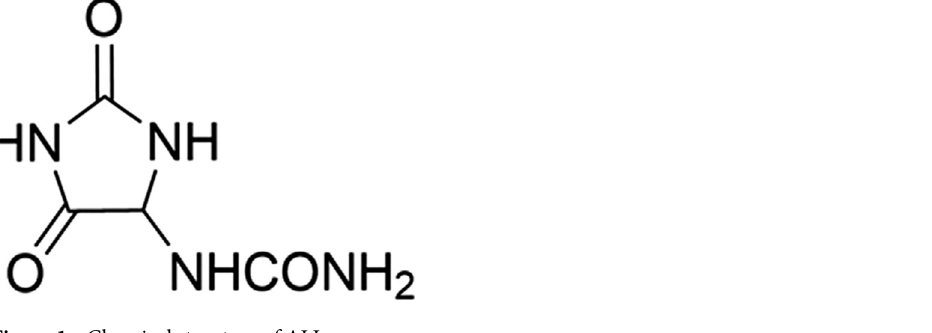
Figure 1. Chemical structure of